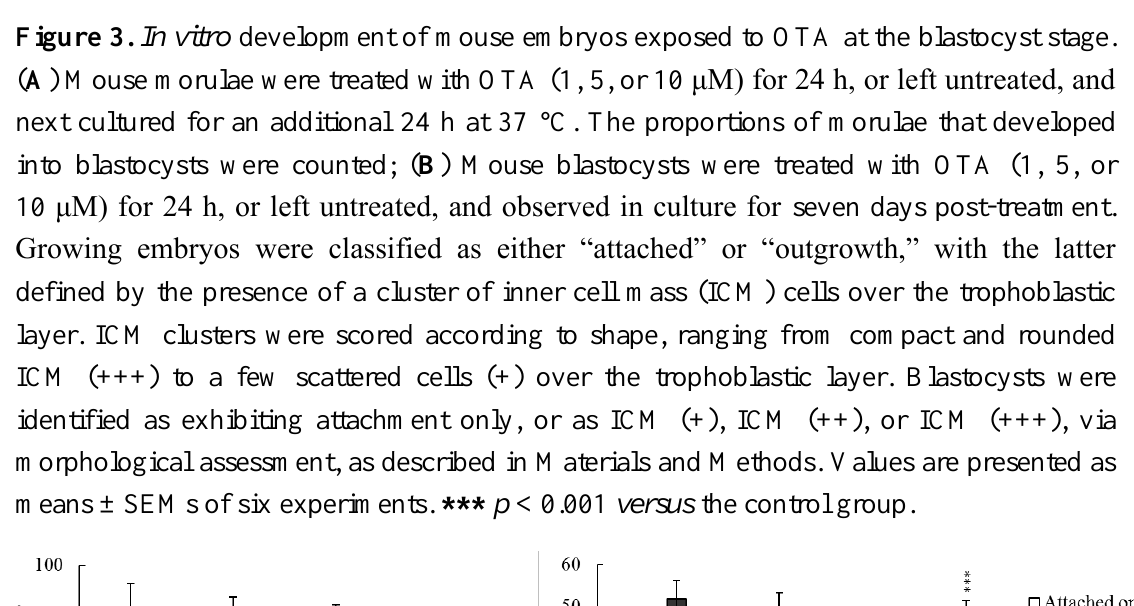
Figure 3. In vitro development of mouse embryos exposed to OTA at the blastocyst